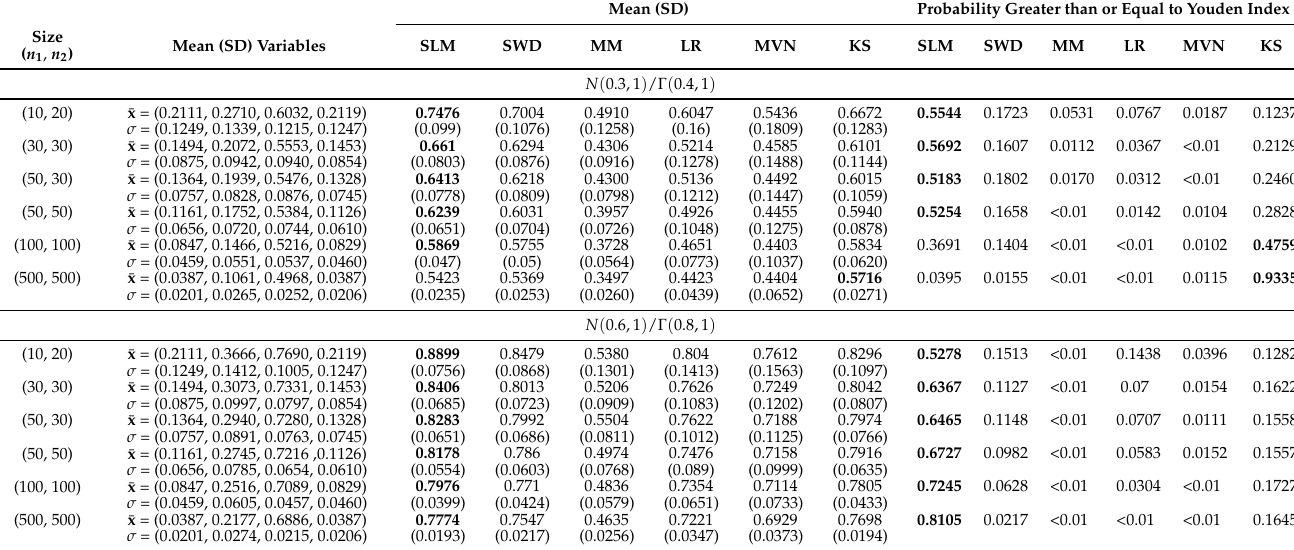
Table 9. Non-normal distributions: Different marginal